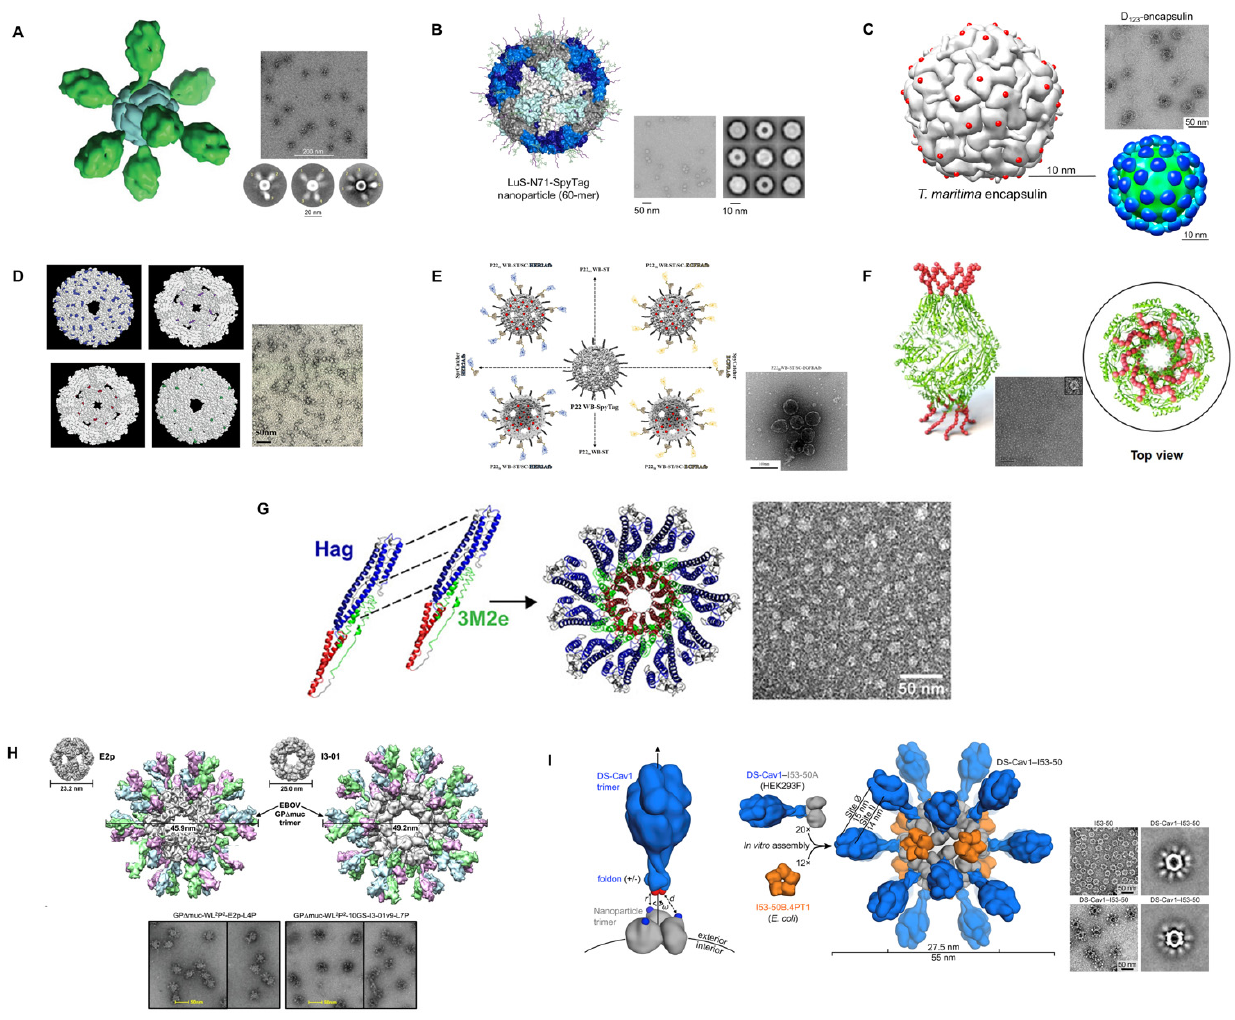
Figure 5. Selected illustrations of self-assembling bacterial proteins as nanoscaffolds for antigen de- livery. ( A ) ferritin nanoparticle with the Fusion (RSV) antigen [100]. ( B ) lumazine synthase-N71-